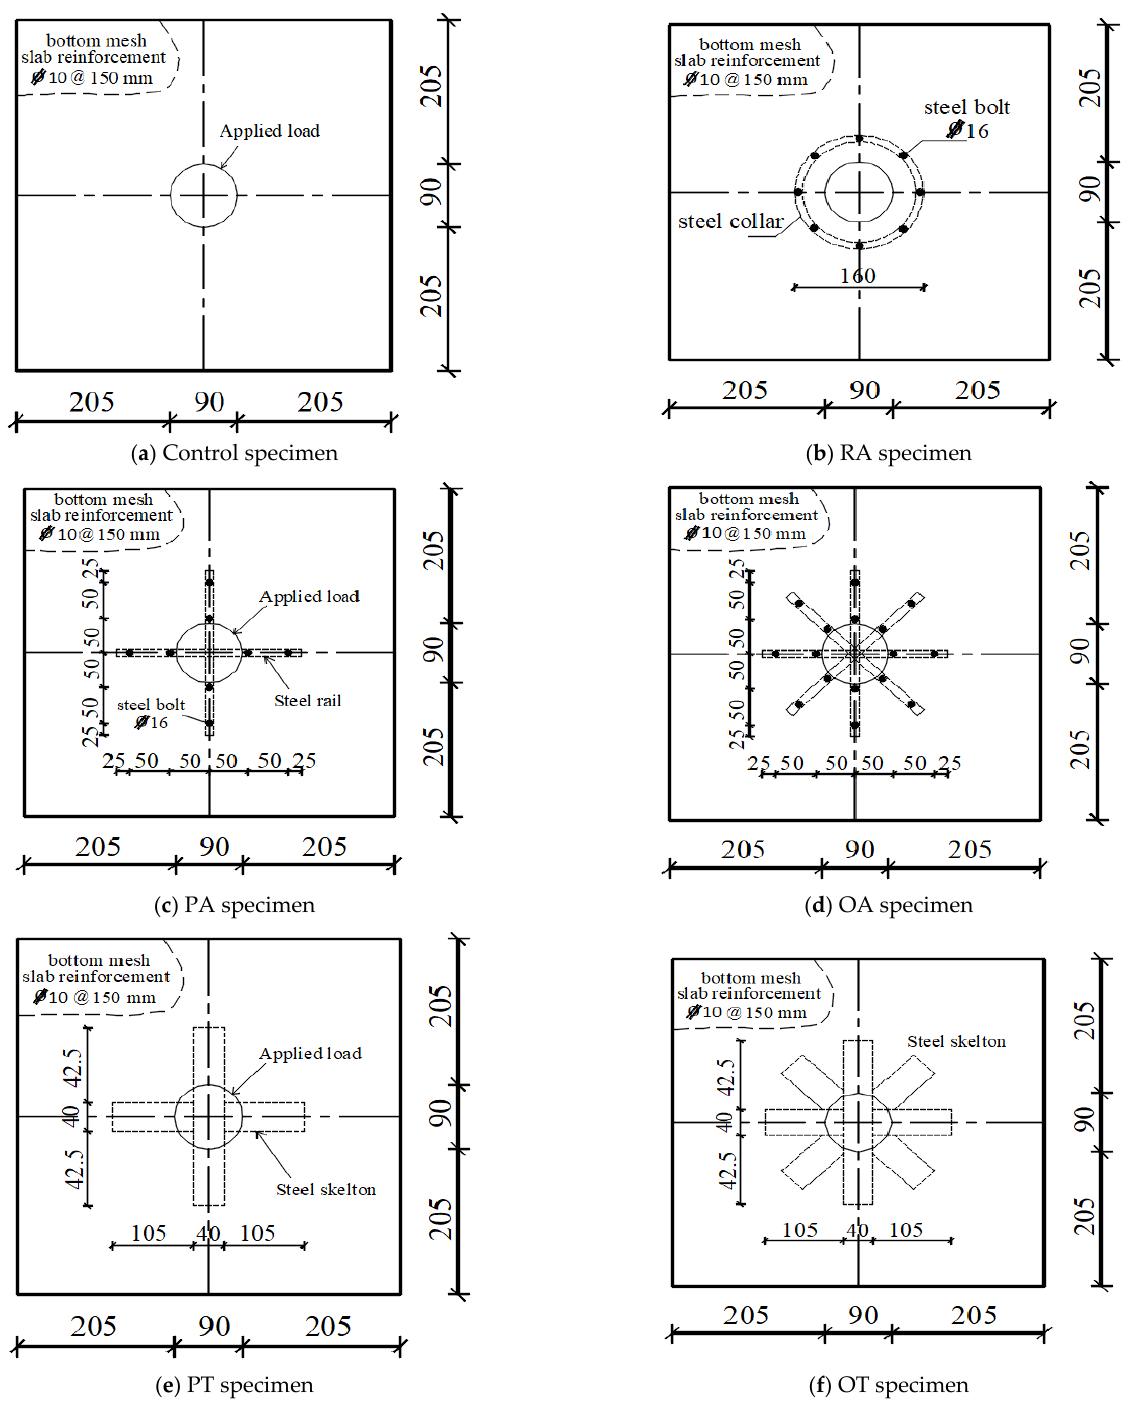
Figure 2. Dimensions and details of specimen configurations.